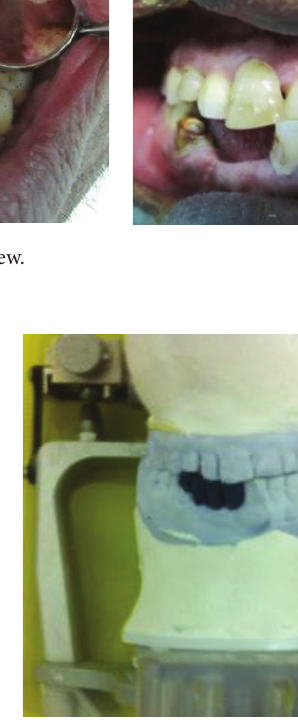
Figure 5: Diagnostic wax-up on mandibular